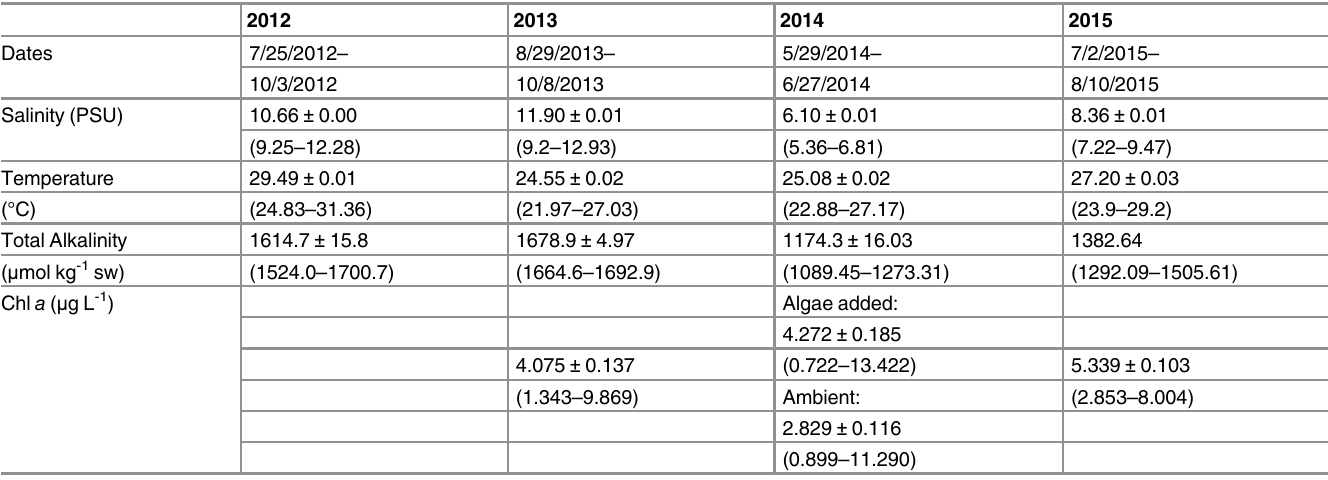
Table 5. Experimental dates, mean ± SE and range of water quality parameters in treatment aquaria during growth experiments 2012 –